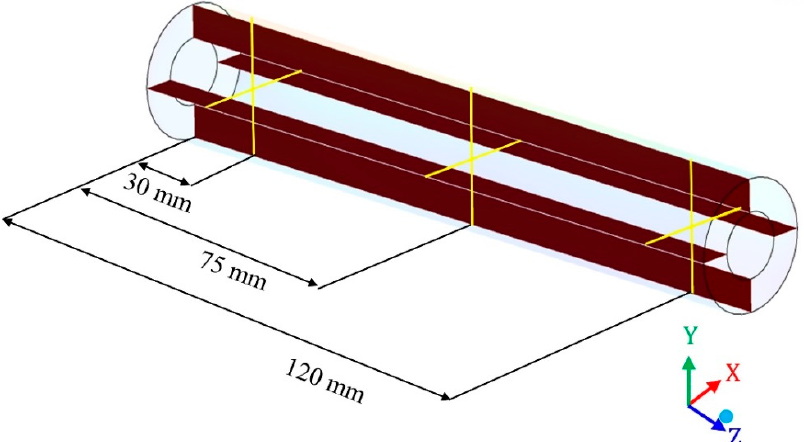
Figure 6. Vertical longitudinal planes and horizontal longitudinal planes in the membrane region, chosen for data analysis.